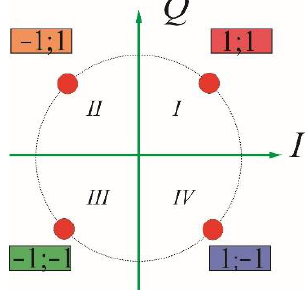
Fig. 2. QPSK signal